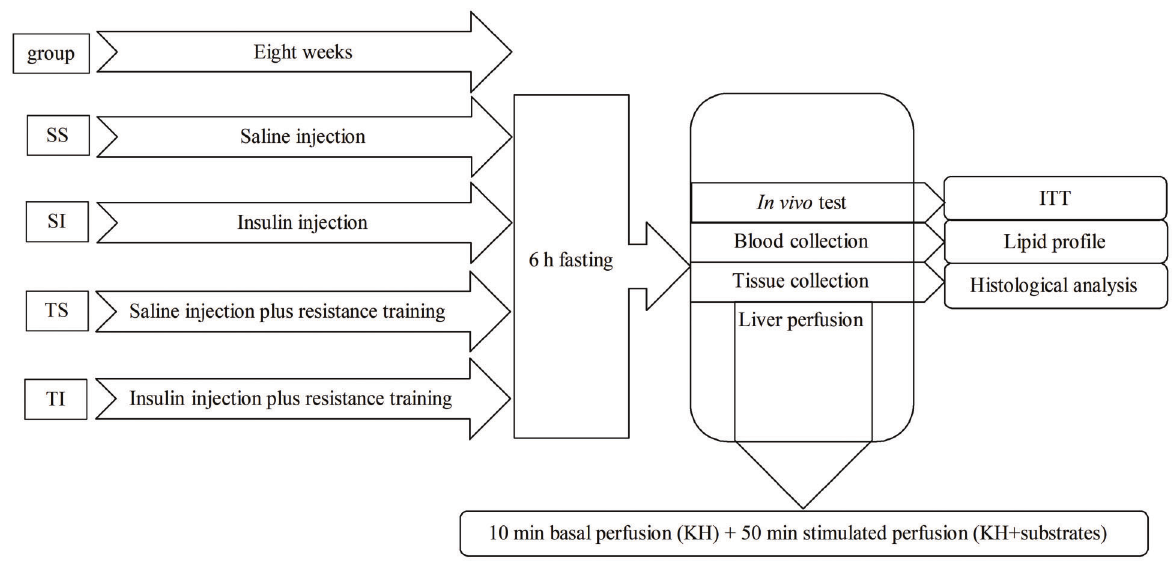
Figure 1. Schematic representation of the experimental protocols of Swiss mice of groups SS: sedentary treated with saline; SI: sedentary treated with insulin; TS: trained treated with saline; and TI: trained treated with insulin. ITT: insulin tolerance test; KH: